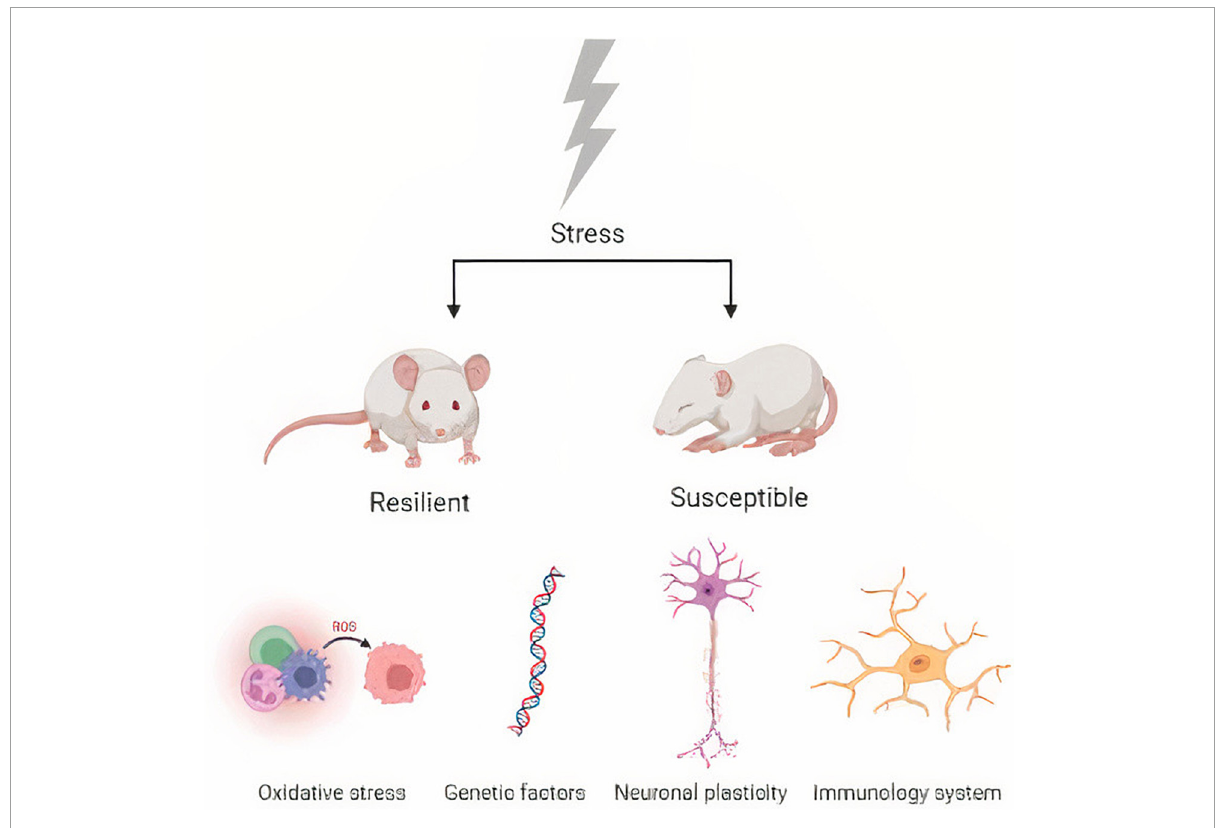
FIGURE1 Biological mechanisms of stress susceptibility and